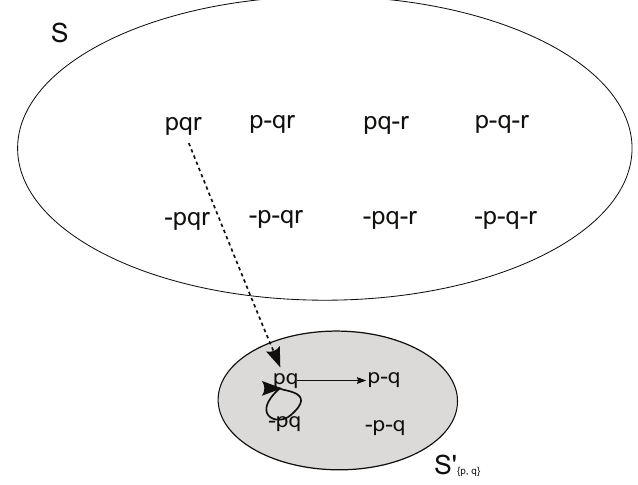
Figure 3. Projection of an objective state in a subjective state